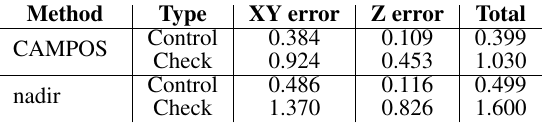
Table 1. GCPs root mean square error, units in meters.